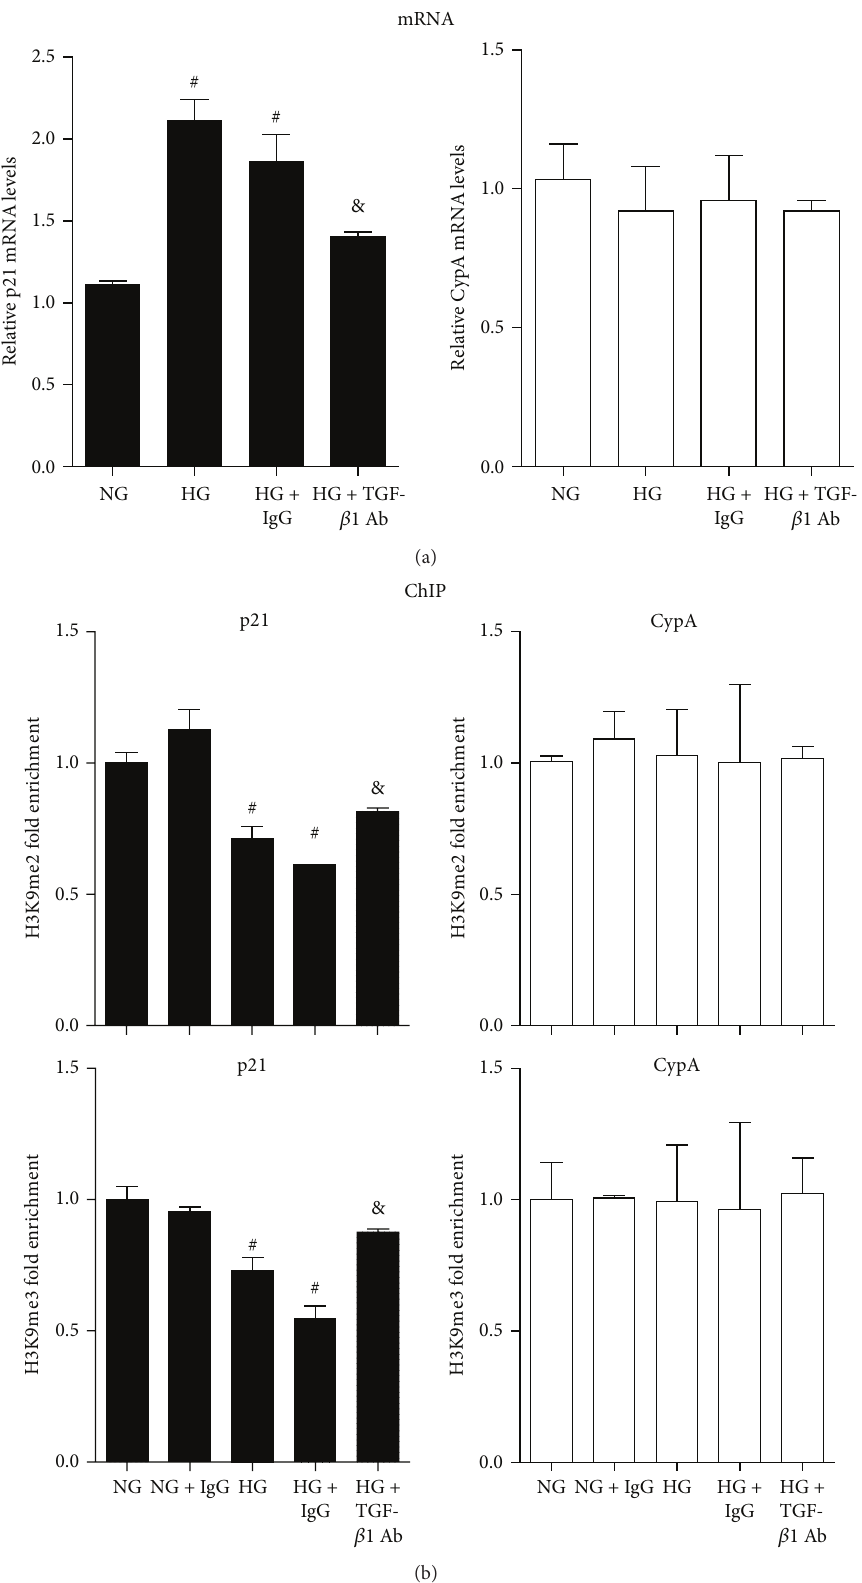
Figure 4: TGF- 𝛽 1-specific antibody reversed HG-induced p21 gene expression and H3K9me2/3 changes at p21 gene promoter in RMCs. (a) p21 gene mRNA levels in RMCs. Serum-depleted RMCs were treated as described in Materials and Methods. Gene expression was analyzed by RT-qPCR, and results were expressed as fold over NG group (mean ± SEM; # 𝑃 < 0.05 compared to NG; & 𝑃 < 0.05 compared to HG, 𝑛 = 3 ). (b) H3K9me2/3 levels at p21 and CypA gene promoters in RMCs. ChIP assays were performed as described in Materials and Methods. Results were expressed as fold over NG (mean ± SEM; # 𝑃 < 0.05 compared to NG; & 𝑃 < 0.05 compared to HG, 𝑛 = 3